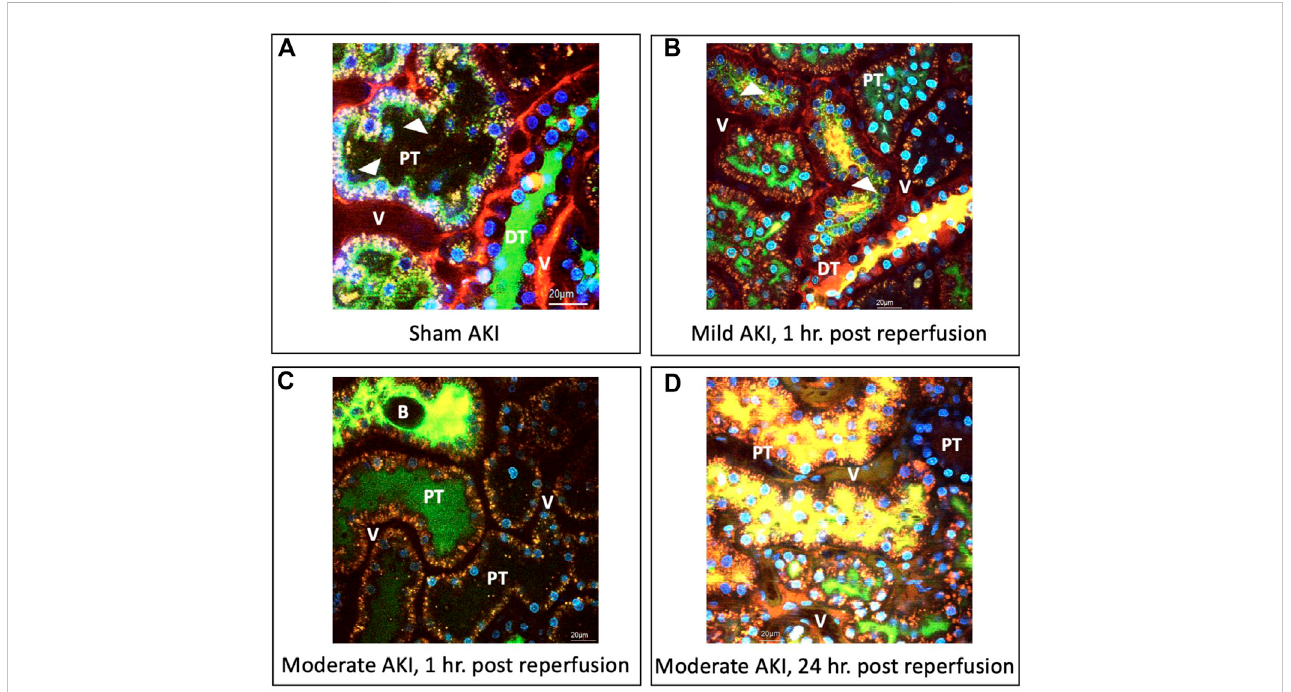
FIGURE 3 Intravital micrographs illustrate the incorporation of macromolecules by various renal compartments resulting from renal vein hydrodynamic injections performed in (A) sham injured rats and those with (B) mild AKI (injections performed 1 h after inducing AKI), (C) moderate AKI (injections performed 1 h after inducing AKI),and (D) moderateAKI(injectionsperformed24 hafter inducingAKI).Thesemicrographswereacquiredfromliveratswithin 20 minofreceiving hydrodynamic infusions of 0.5 mL saline containing 4 kDa FITC and 150 kDa TRITC dextrans, and Hoechst 33,342 (this image A was acquired with 1.5X digital zoom to illustrate better the dynamic events outlined). The arrowheads highlight regions where the fl uorescent dextran molecules appear to bound brushbordersorendocytosedpunctawithintubularepithelialcells.Allimagesweretakenusingablendofthered-,green-,andblue-pseudo-colorchannels. DT, distal tubule; PT, proximal tubule; and V, vasculature; and B, bleb, observed within the tubular